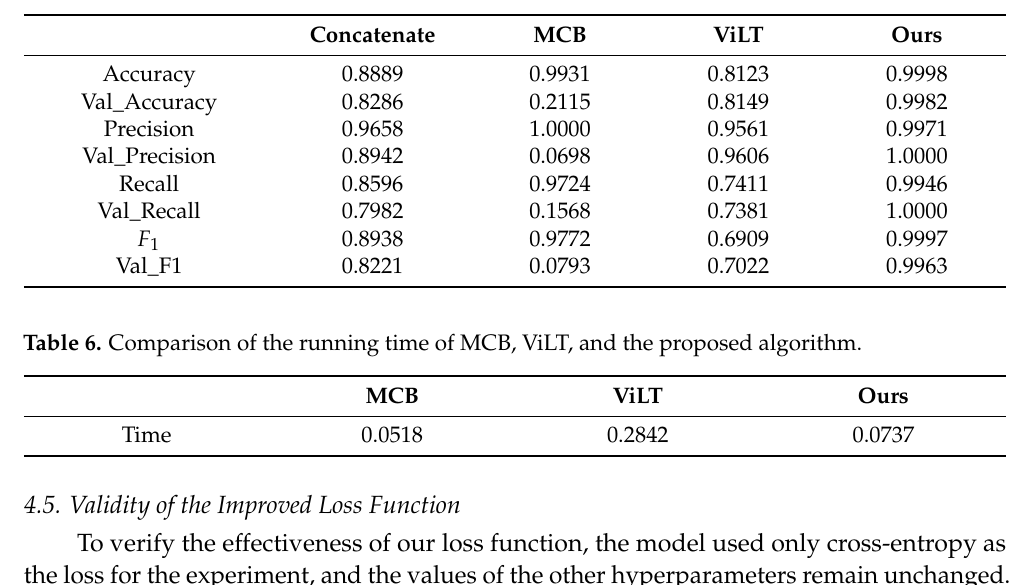
Table 5. Comparative experimental results on the Amazon dataset. Note: Val_Accuracy,